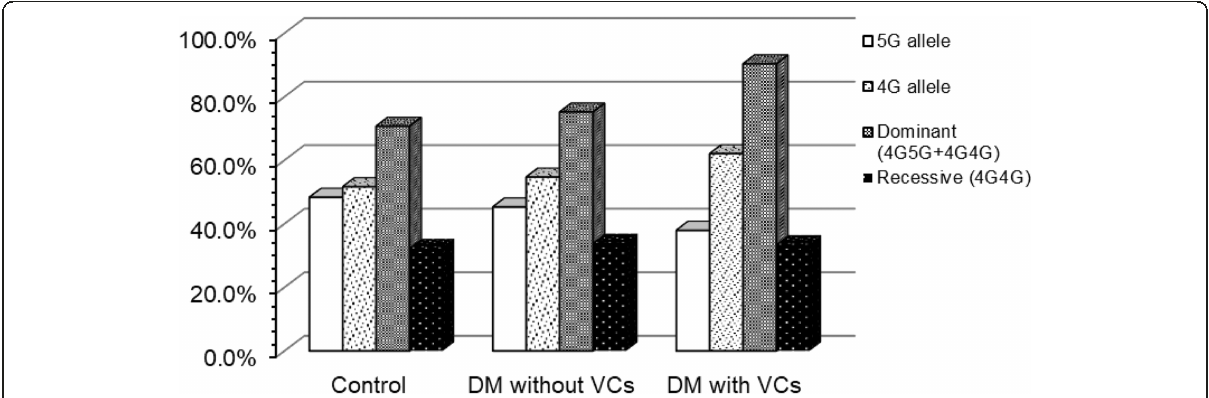
Fig. 2 Allelic frequencies, dominant and recessive genotypes of PAI-1 gene polymorphism in the studid groups